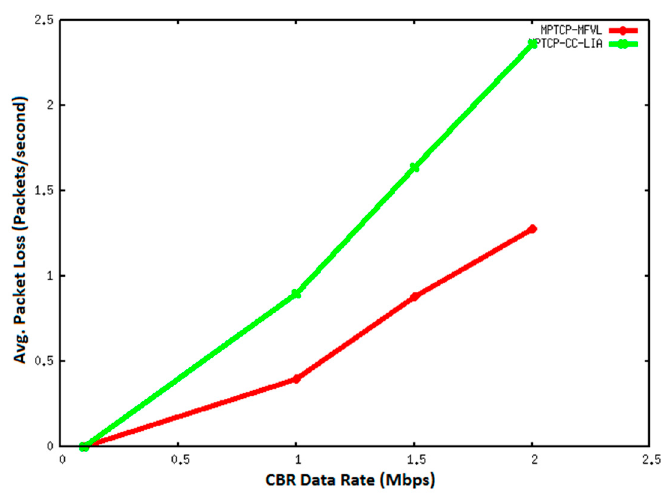
Figure 20. Average packet loss rate with CBR data rate 0.1 to 2 Mbps.